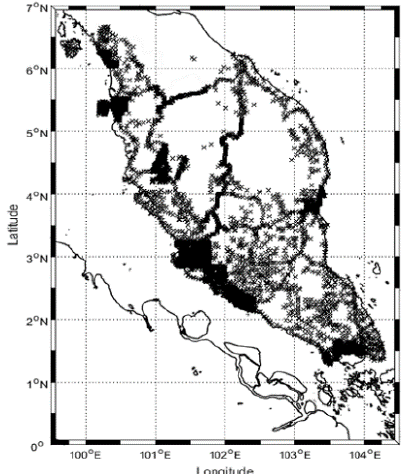
Figure 1. Distribution of land gravity stations over Peninsular Malaysia